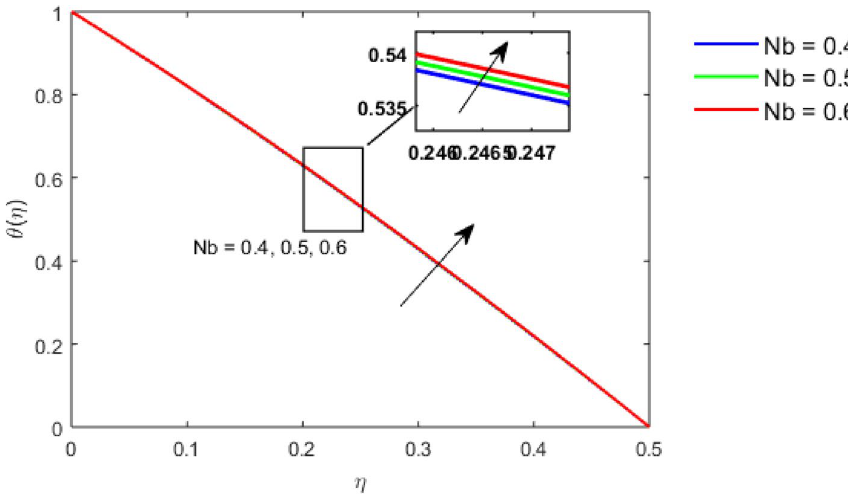
Figure 13. Thermal profile for increasing Nb , for Pseudoplastic fluid by keeping m = 0.8 .